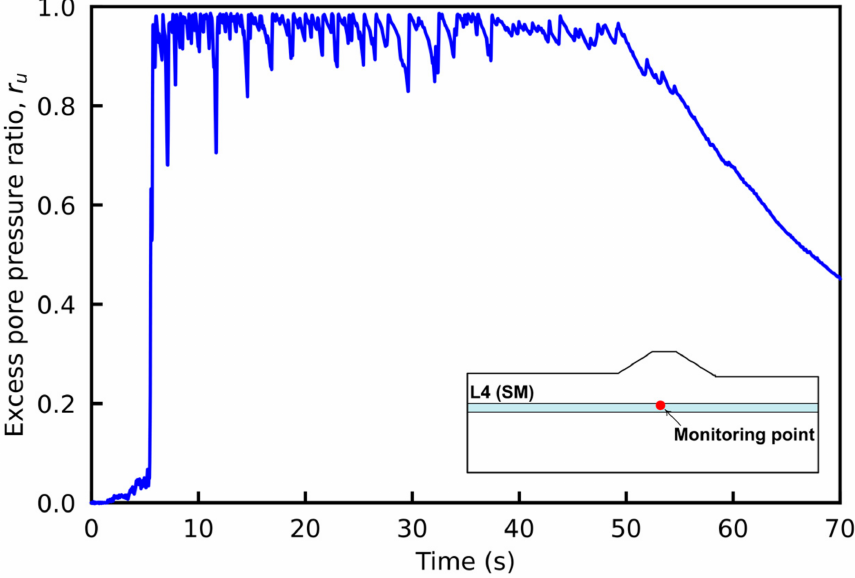
Figure 20. The EPWP ratio history at the central element of L4 layer during the